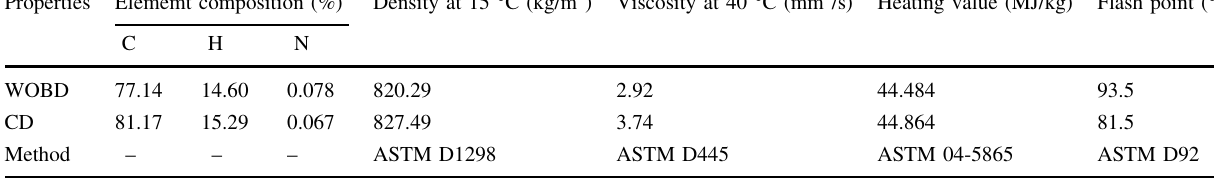
Table 1 Physical and chemical properties of tested fuels Properties Elememt composition